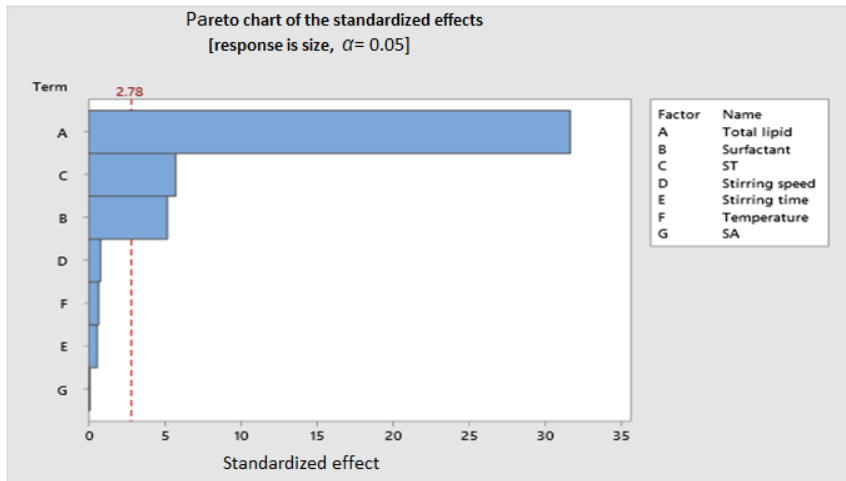
Figure 6. Pareto chart representing the effect of different factors (CMAs and CPPs) on the response (CQAs). Bars crossing the reference line are statistically significant. Bars that represent factors A, B, and C cross the reference line that is at 2.78 (reference line 2.78 was generated by the software Minitab). These factors are statistically significant at the 0.05 level with the current model terms. Factor A is representing the highest effect followed by C and